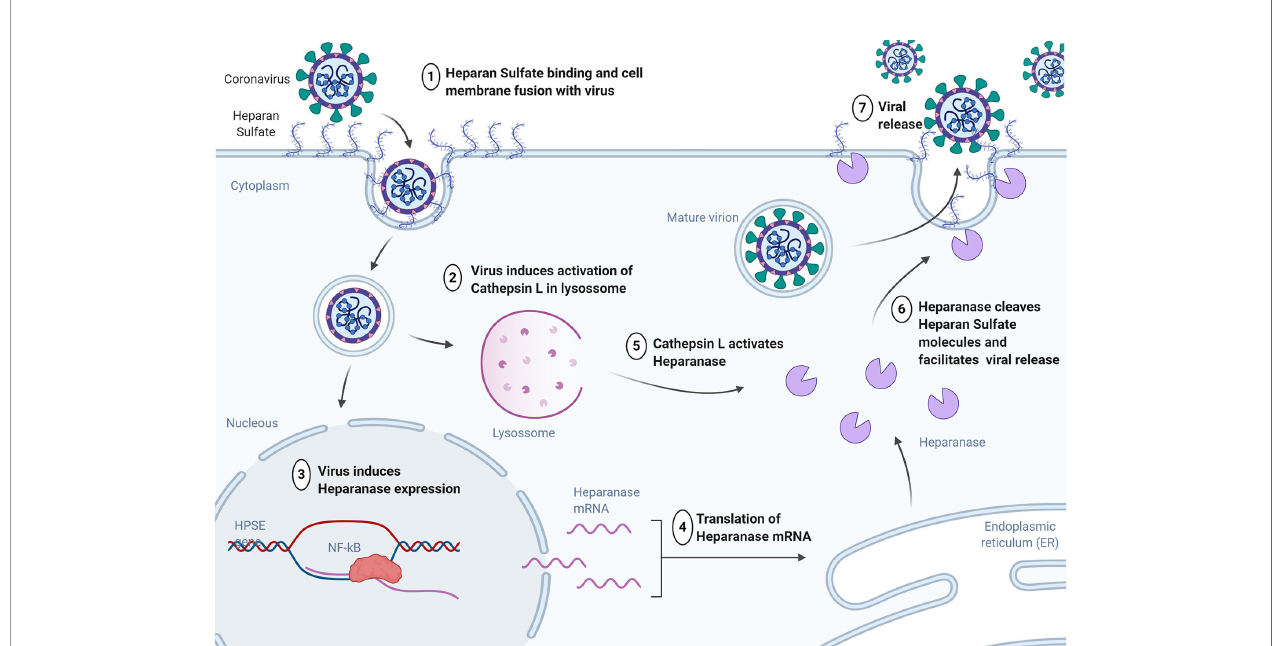
FIGURE 2 | Heparan Sulfate expression increases during the initial stage of viral infection to enhance viral attachment to cells. Virus inside of cell induces activation of cathepsin L in lysosome and promotes upregulation of heparanase expression through the NF-kB signaling pathway. Heparanase protein is activated by Cathepsin L and is translocated to the cell surface for the removal of heparan sulfate to facilitate viral release. HPSE, heparanase gene; NF-kB, nuclear factor kappa beta. (Created in